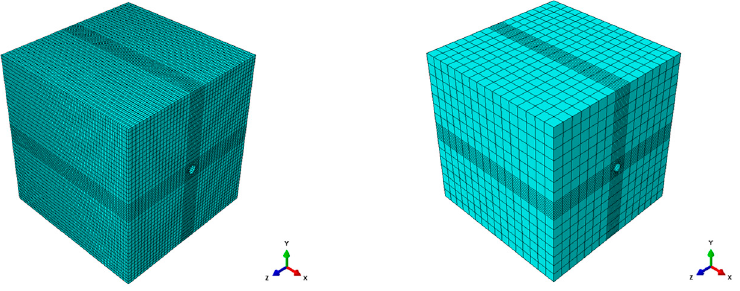
Figure 14. Comparison of a fine concrete mesh ( left ) and coarse concrete mesh ( right ).